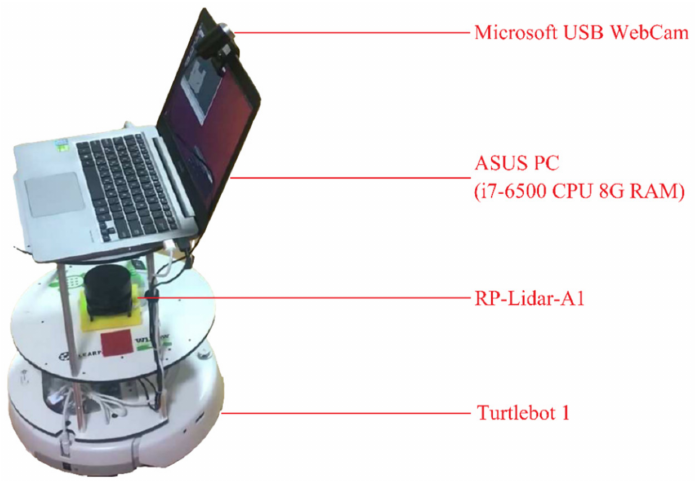
Figure 31. Turtlebot hardware configuration.